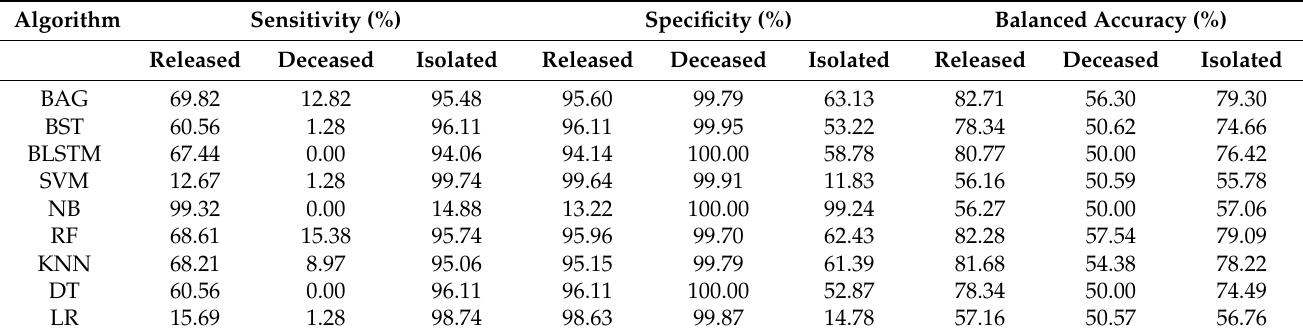
Table 8. Performance of CNN on BAG, BST, BLSTM, SVM, NB, RF, KNN, DT, and LR.